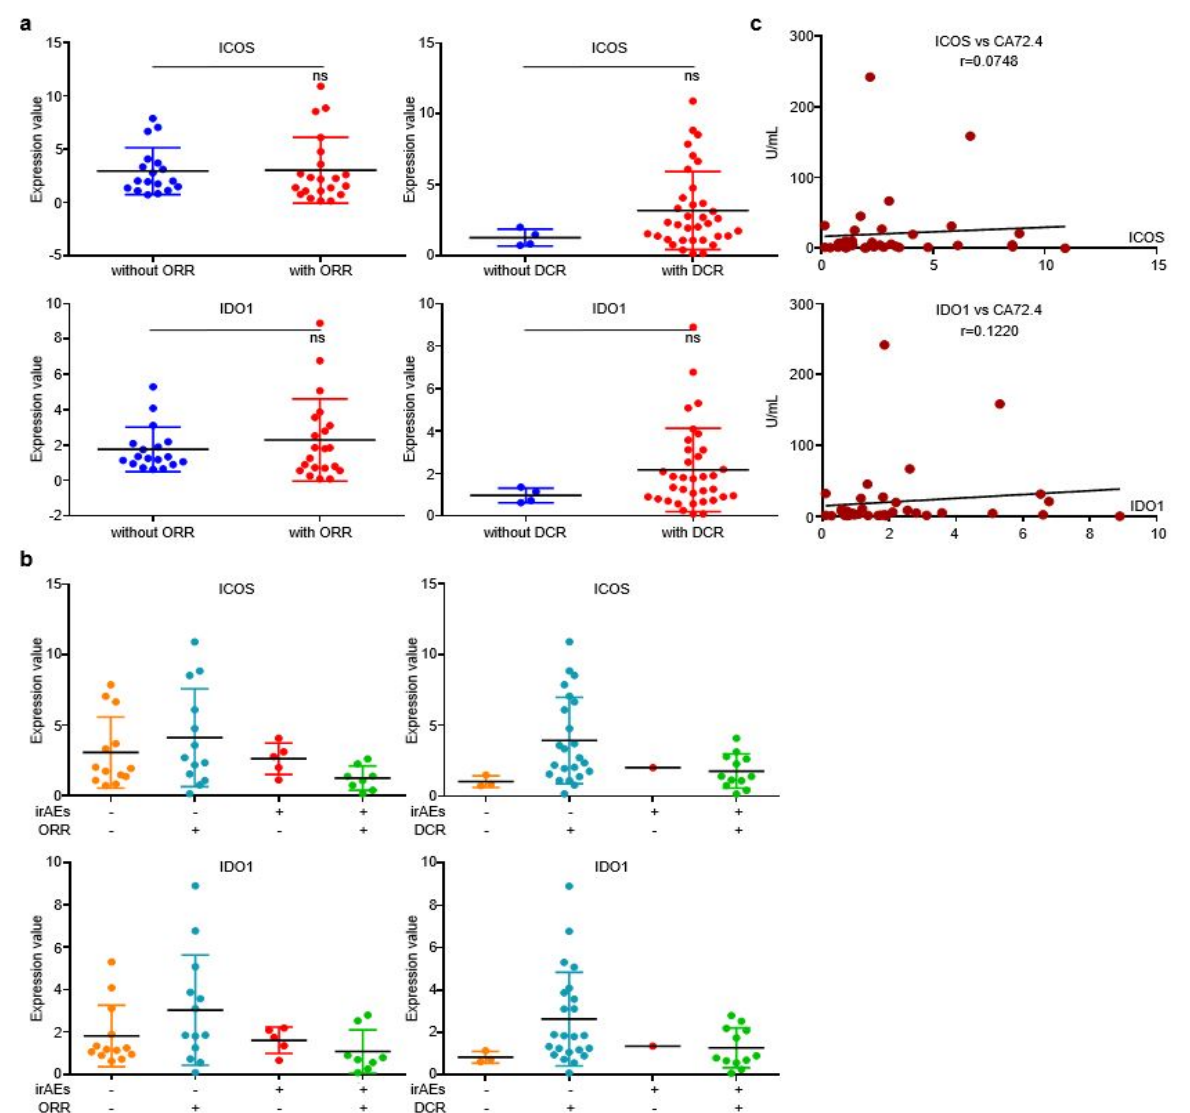
Figure 6. EV-ICOS/IDO1 was largely irrelevant to immunotherapeutic effectiveness in validating cohort. ( a ) EV-ICOS/IDO1 had no correlation with ORR/DCR. ( b ) The higher values of EV-ICOS/IDO1 predict the lower occurrence of irAEs in ORR/DCR reached patients. ( c ) EV-ICOS/IDO1 had a strong correlation with CA72.4. Different colors represent distinct irAEs and DCR status. ns, non-significant.